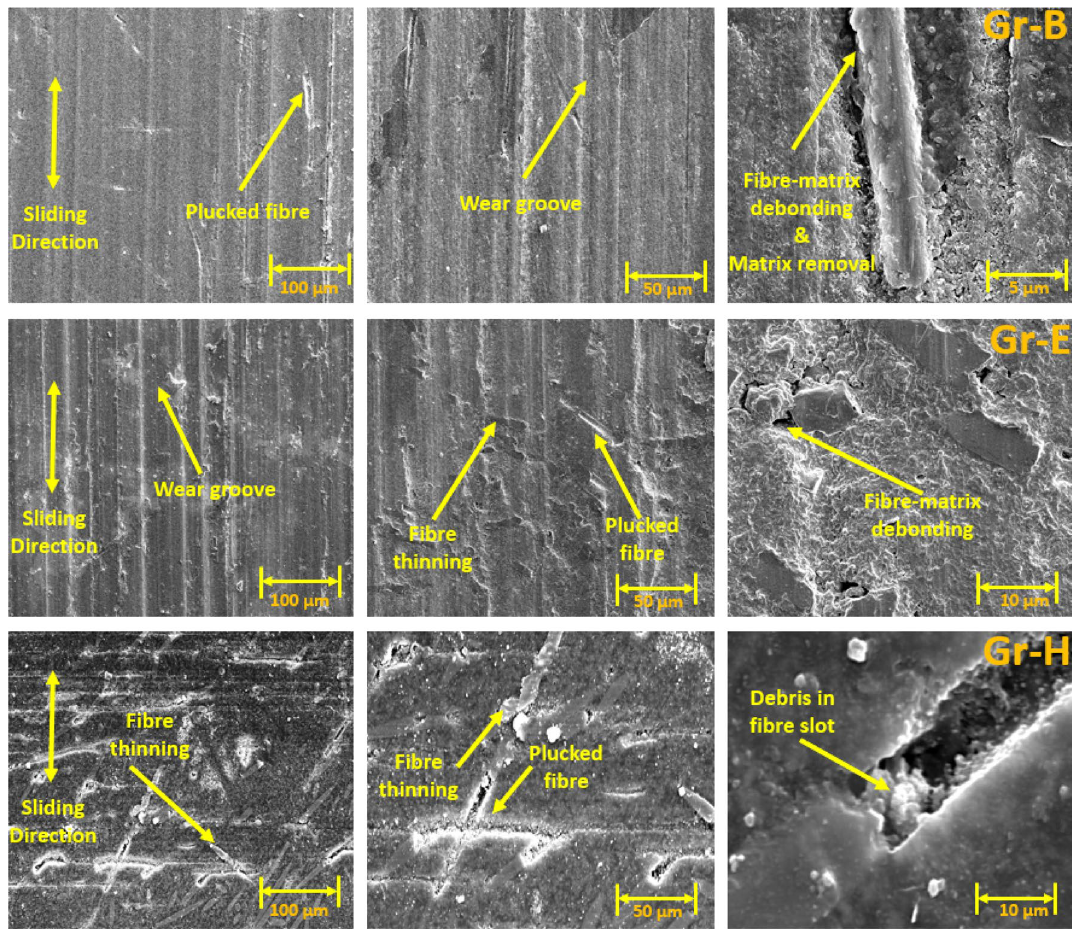
Figure 5. SEM images of 50 AR Group B (5 wt%), Group E (10 wt%) and Group H (15